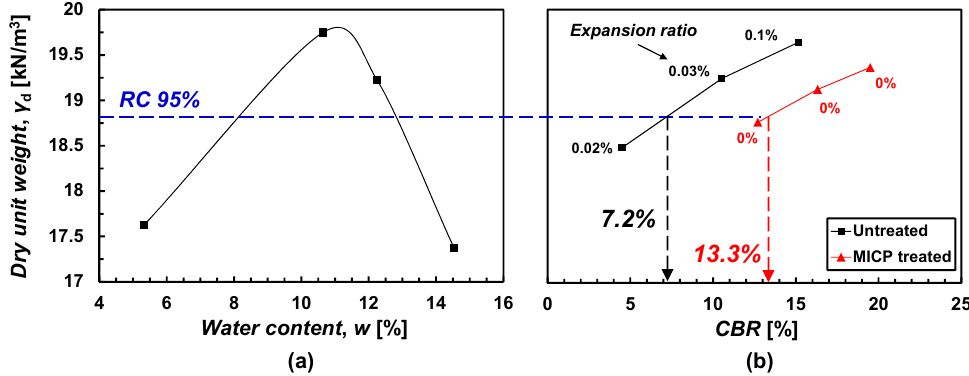
Figure 8. Modified CBR test results on untreated and MICP-treated specimens. ( a ) compaction curve and ( b ) CBR curves.